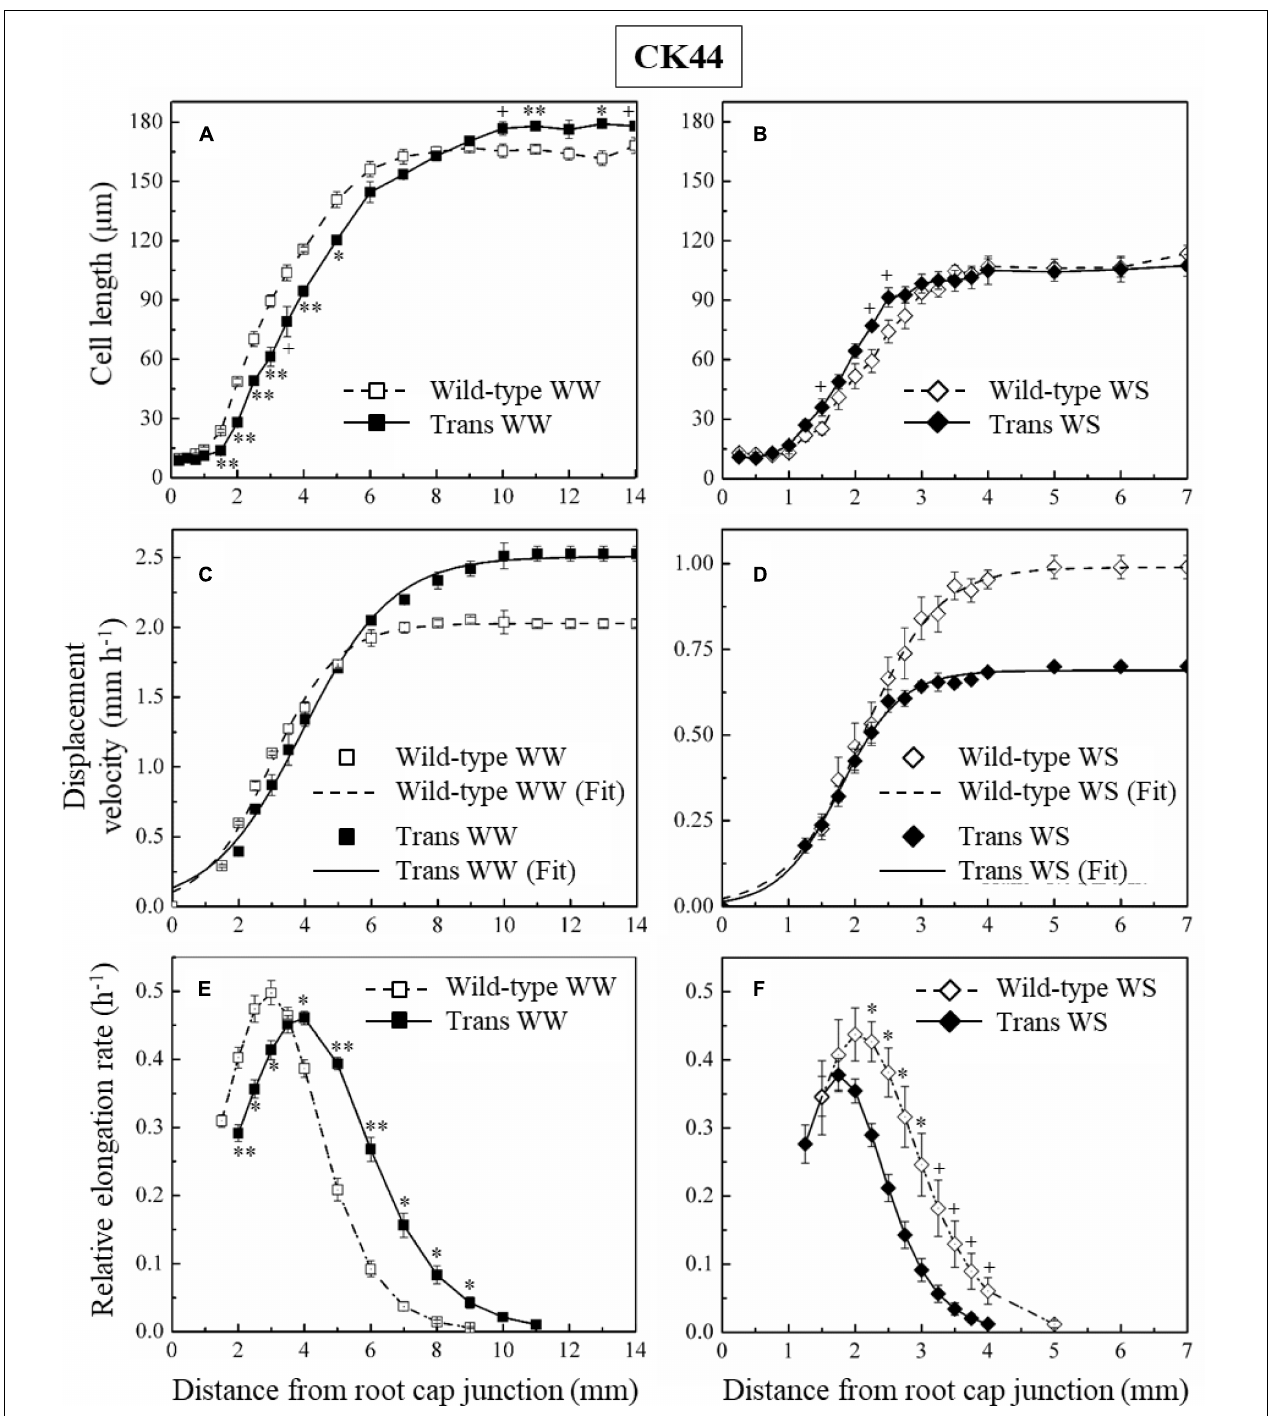
FIGURE 5 | Cortical cell length profiles (A,B) , displacement velocity profiles (C,D) , and relative elongation rate profiles (E,F) as a function of distance from the root cap junction in the primary root of CK44 oxalate oxidase transgenic (Trans) and wild-type lines growing under well-watered (WW) or water-stressed (WS; –1.6 MPa) conditions. (In the water-stressed roots, cell lengths were also measured from 8 to 10 mm from the apex, but are not shown for clarity). Derivatives of sigmoidal curves fitted to the displacement velocity profiles of individual roots were used to obtain the mean relative elongation rate profiles. For clarity, only the curves fitting the mean velocity profiles (Fit) are shown, for which the goodness of fit ( R 2 ) was > 0.99 in all cases. Roots were harvested 48 h after transplanting to well-watered conditions and 72 h after transplanting to water-stressed conditions; values are means ± SE of three to four roots. Significant differences between the transgenic and wild-type lines are shown for the cell length and relative elongation rate data ( t -test; + P < 0.1; ∗ P < 0.05; ∗∗ P < 0.01). The experiments were repeated with similar results.